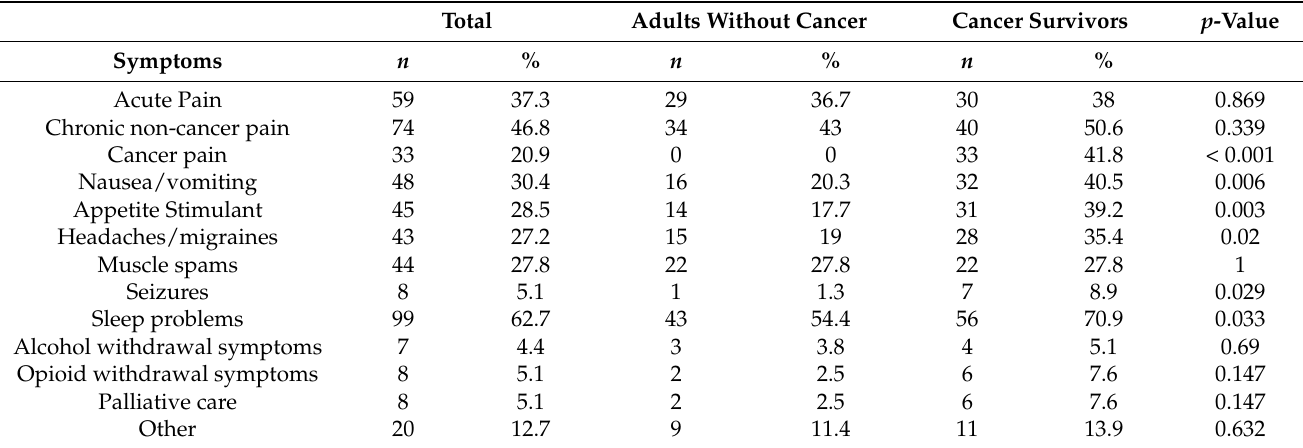
Table 2. Self-Reported Symptoms Managed Using Cannabis of the COVID-19 Cannabis Health Questionnaire respondents